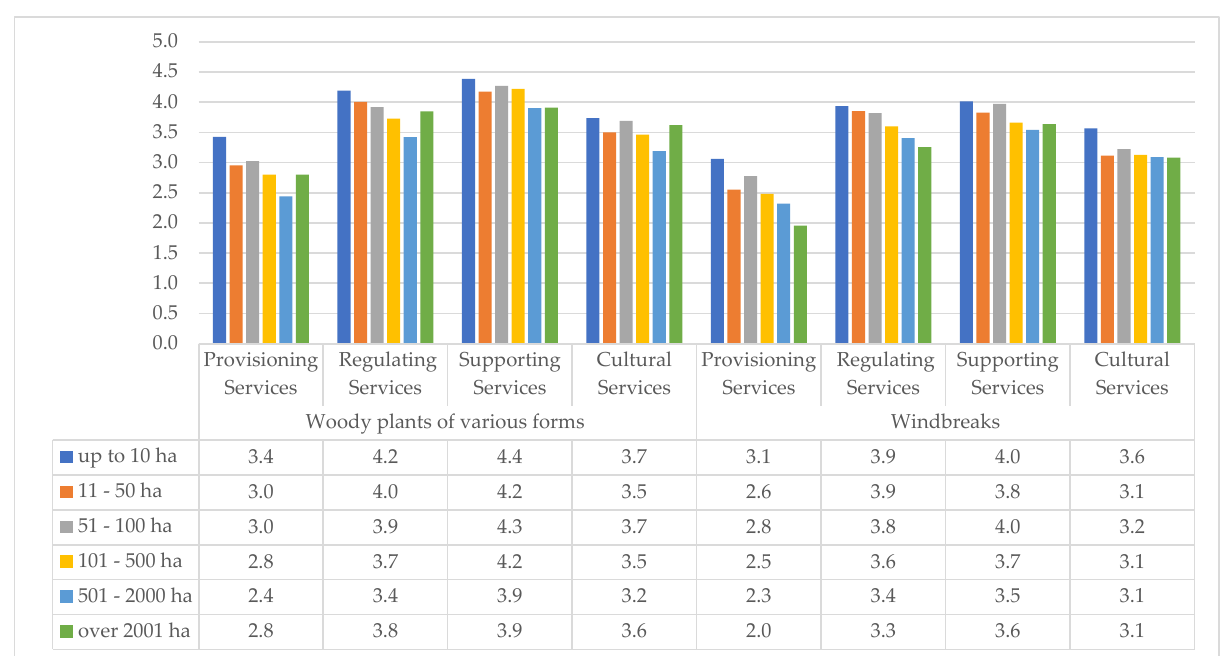
Figure 7. Average rating of the importance of ES in relation to the size of the cultivated land.